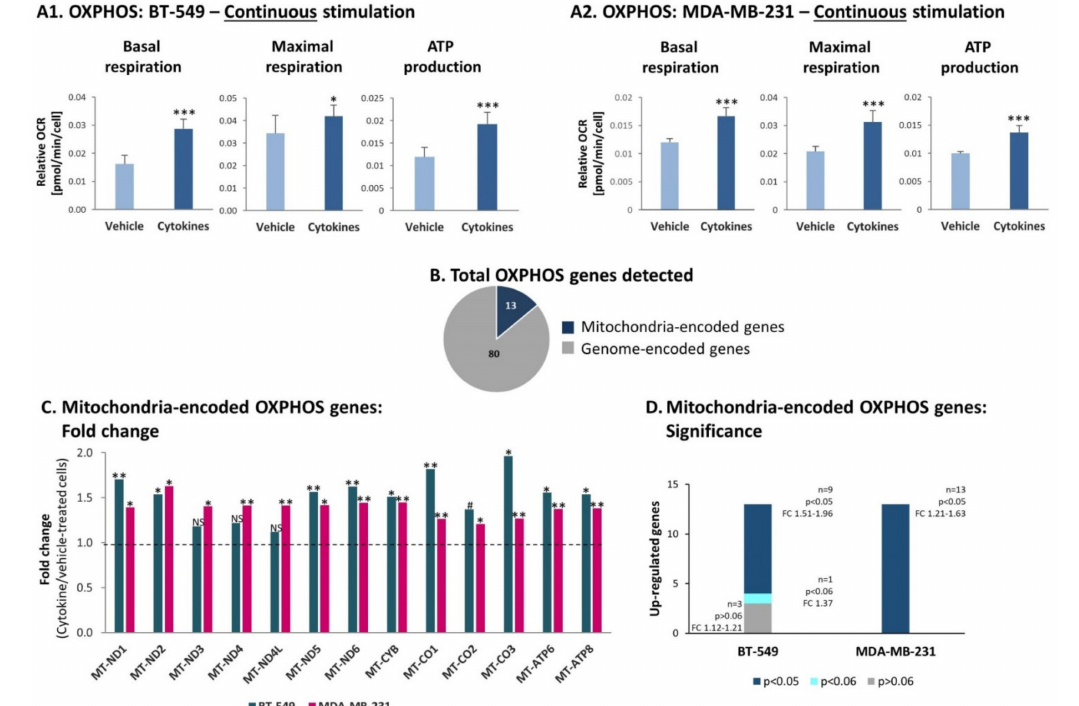
Figure 8. Continuous TNF α + IL-1 β stimulation increases OXPHOS in TNBC cells, accompanied by elevated transcription levels of mitochondria-encoded OXPHOS genes. BT-549 and MDA-MB-231 cells were continuously stimulated by TNF α + IL- 1 β , or treated by vehicle control (as described in Figure 1). ( A ) OXPHOS-related activities were determined by the seahorse technology. ( A1 ) BT-549 cells. ( A2 ) MDA-MB-231 cells. The results of a representative experiment of n>3 are presented. *** p < 0.001, * p < 0.05. ( B ) A chart demonstrating the numbers of OXPHOS genes encoded in the nucleus genome and Figure 2). ( C ) Fold change in expression of mitochondria-encoded OXPHOS genes, comparing between cytokine-stimulated and vehicle-treated cells, determined by the transcriptome analyses (described in Figure 2). ** p < 0.01, * p < 0.05, # p < 0.06. NS, not significant. ( D ) A graph demonstrating the significance values of alterations observed in mitochondria-encoded OXPHOS genes in BT-549 cells and MDA-MB-231 cells. The alterations in gene expression were determined by the transcriptome analyses (described in Figure